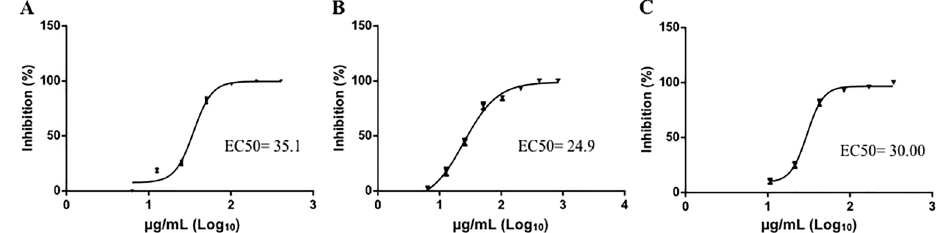
Figure 5. Plaque inhibition analysis of saponins against dengue virus (DENV-2) by virucidal assay. The virus was treated with 2-fold serial dilutions of the saponins S1 ( A ), S2 ( B ), and S3 ( C ) isolated from the roots of S. sisymbriifolium for 1 h. The treated DENV-2 was used to infect monolayers of Vero E6 cells growing in a 24-well plate for 7 days. The number of plaques in the wells with cells infected with the treated virus was compared with the number of plaques in the wells with cells infected with the untreated virus to determine the percentage of plaque reduction. The 50% maximal effective concentration (EC 50 ) value of the saponins was determined by nonlinear regression analysis. The data are reported as means ± SE of quadruplicate wells.